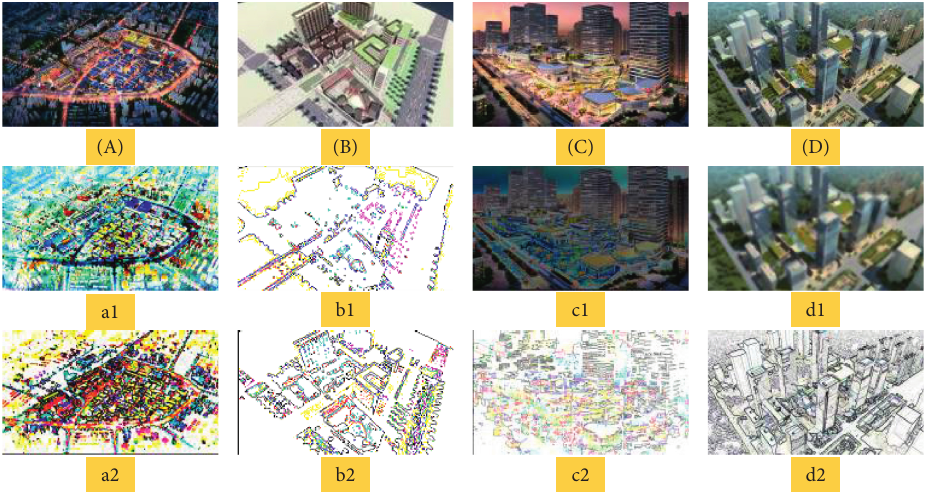
Figure 7: Results of building clustering in the test area.